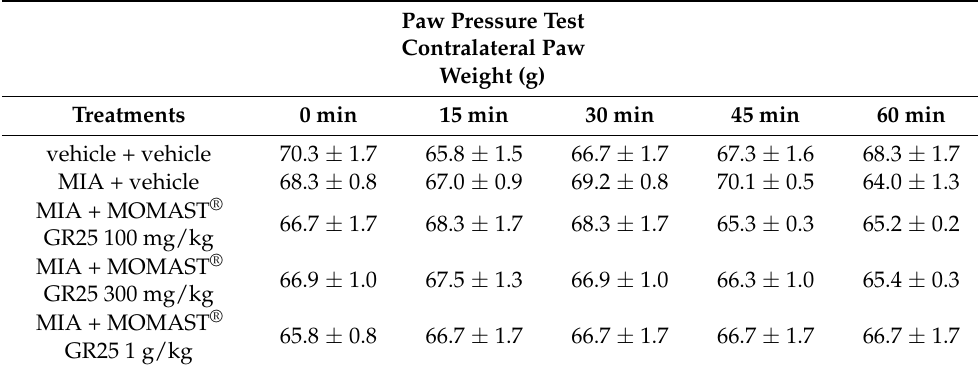
Table 2. Effect of acute administration of MOMAST ® GR25 on MIA-induced osteoarthritis: contralat- eral